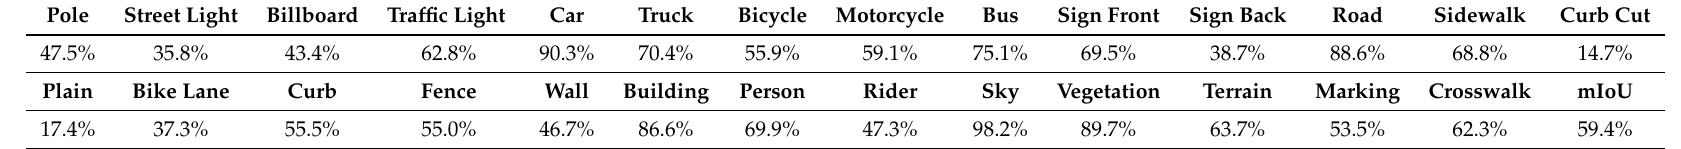
Table 1. Semantic segmentation accuracy for the Mapillary Vistas dataset